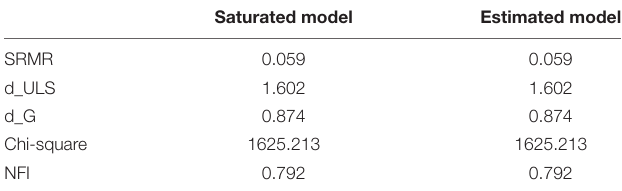
TABLE 7 | Model fitness